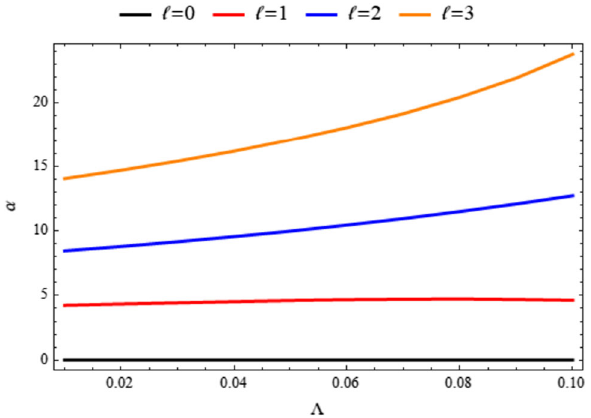
Fig. 6 The unstable/stable region of SdS black hole under massless scalar perturbation with (cid:4) = 0 , 1 , 2 and 3 from fundamental QNM frequency